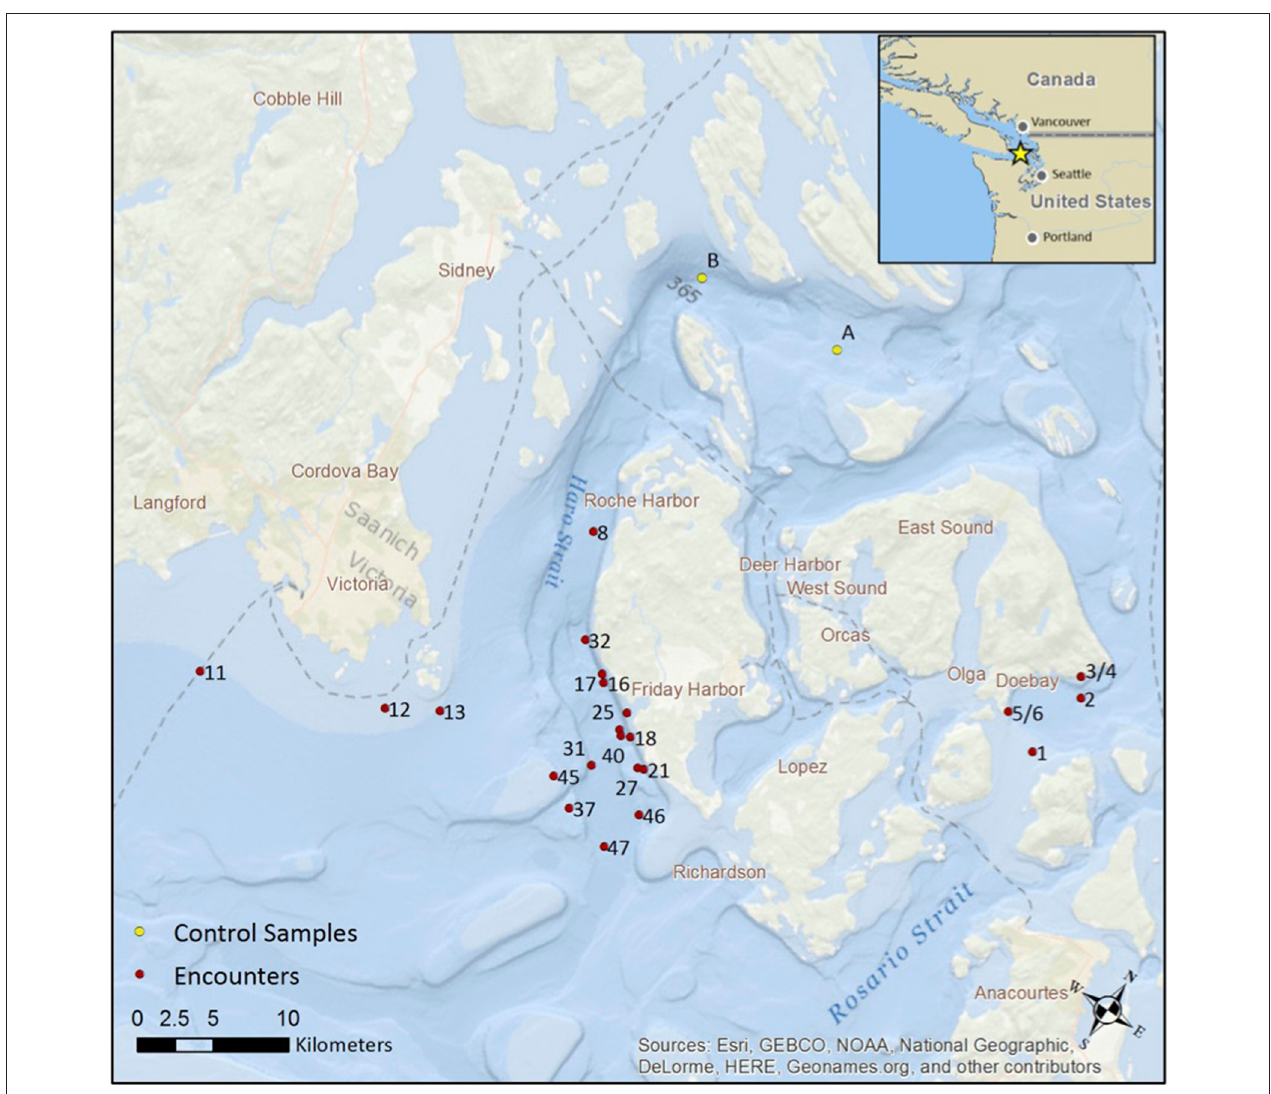
FIGURE 1 | The location of 25 encounters with killer whales in the San Juan Islands during August and September 2015. The red dots show the location of the first eDNA sample, after positioning the vessel at a distance of 200m behind the passage of the whales. The yellow dots show the location of two “no-whale” controls. Note, encounter numbers for collection of eDNA are sequential but not necessarily